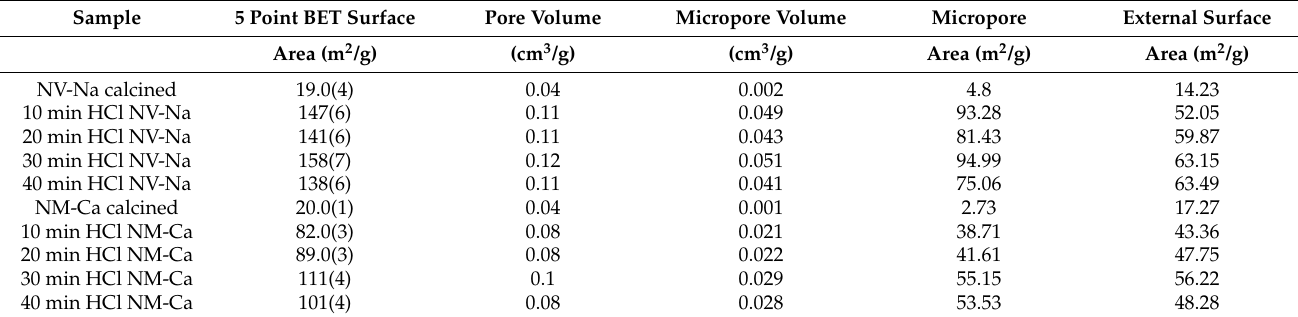
Table 1. The surface area analysis measurements for calcined and HCl etched zeolites.